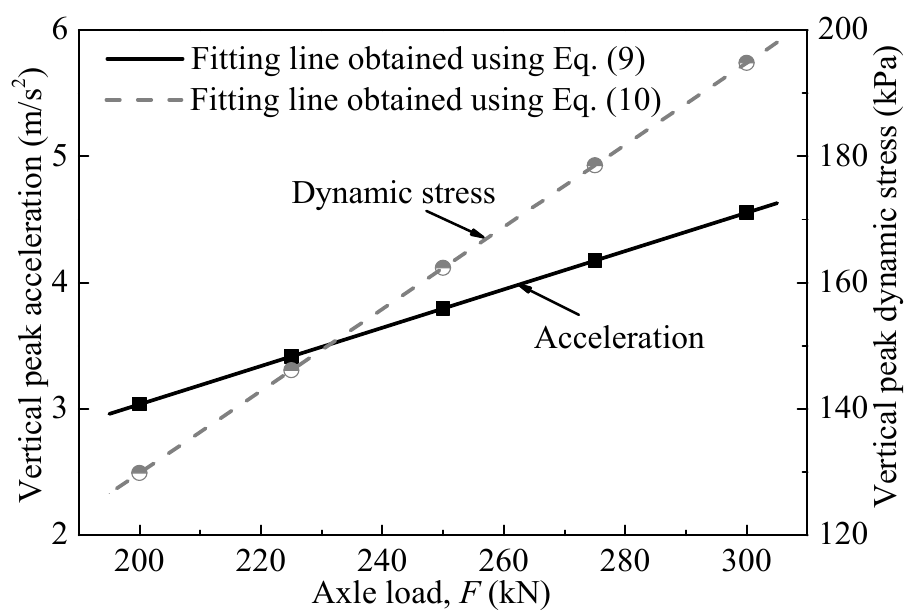
Figure 10. Variation of vertical peak acceleration and dynamic stress at the center of the top layer surface with the axle load.